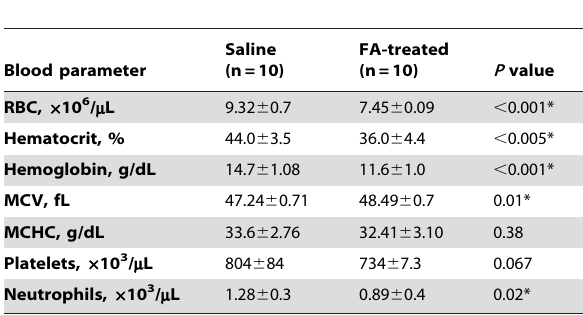
Table 1. Hematologic parameters of C57BL/6 mice treated for 14 days with saline (0.9%) or FA (4 mg/kg/day).